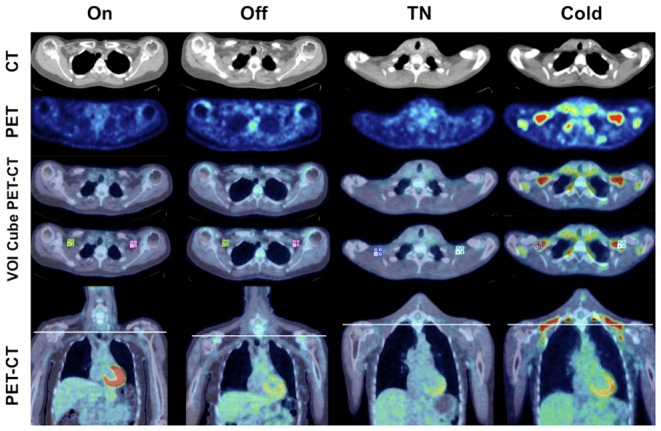
FDG-PET-CT images of intervention group and cold exposed subjects.Transaxial and coronal CT, PET and PET-CT fused images of VNS-On and VNS-Off from a subject in the VNS-On/Off group and images from a subject in the VNS-TN/Cold group during thermoneutral conditions (TN) and cold exposure (Cold). PET-CT image shown with and without Volume-Of-Interest (VOI) cubes for determination of activity. The white line in the coronal image indicates the transaxial slice shown above.